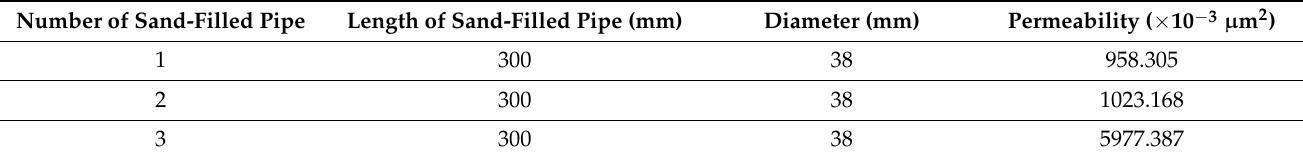
Table 1. Basic physical property of sand-filled pipes.